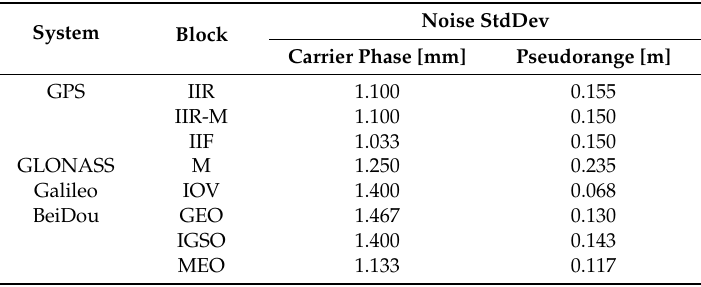
Table 4. Standard deviation of carrier phase and code receiver noises.